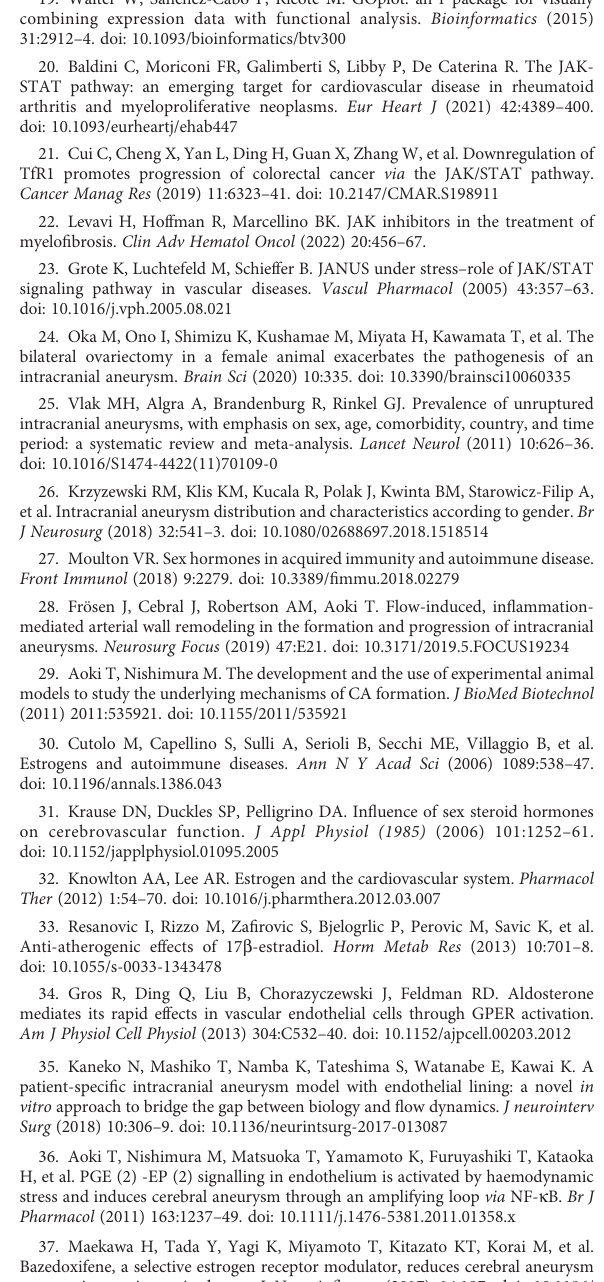
The AUCs of the six characteristic genes of the ERP in GSE75436. (B) The AUC of the combination of the six characteristic genes of the ERP in GSE75436 (C) Cell type enrichment result from